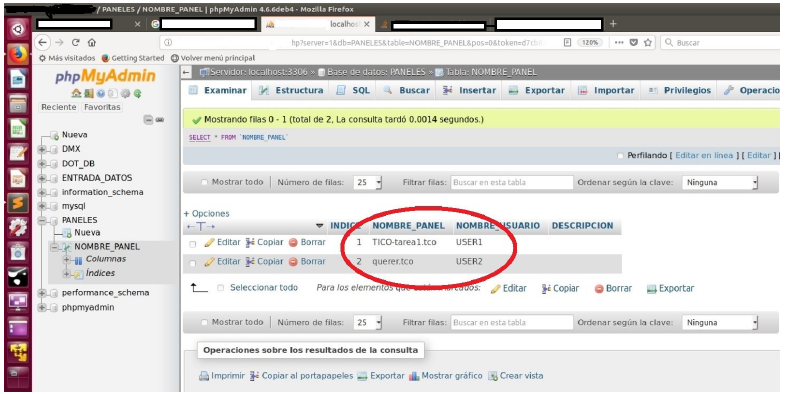
Figure 18. View of the database where TICO panels are imported into time orientation service and associated to different users. associated to different